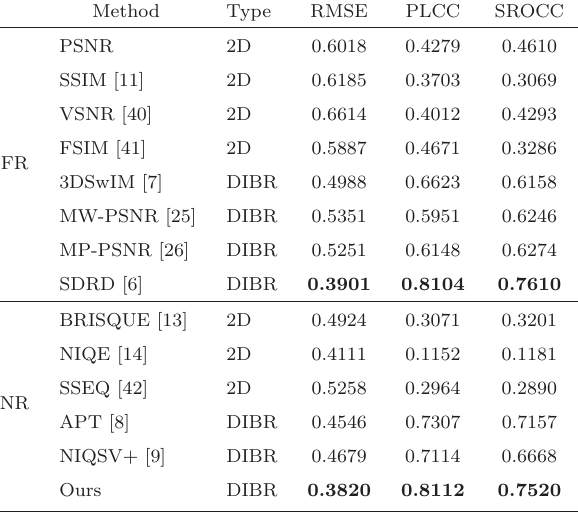
Table 2 RMSE, PLCC, and SROCC on IRCCyN/IVC DIBR image dataset